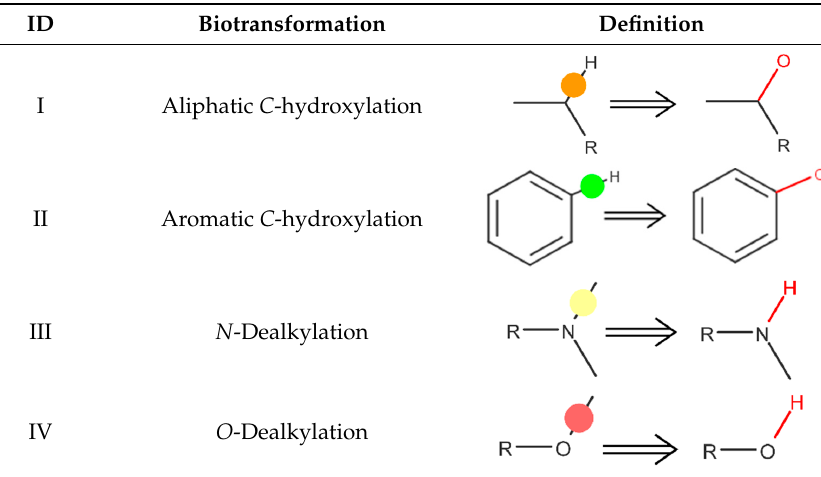
Table 4. Visual graphic definitions of four biotransformations mediated by CYP450 3A4, 2D6, and 2C9.